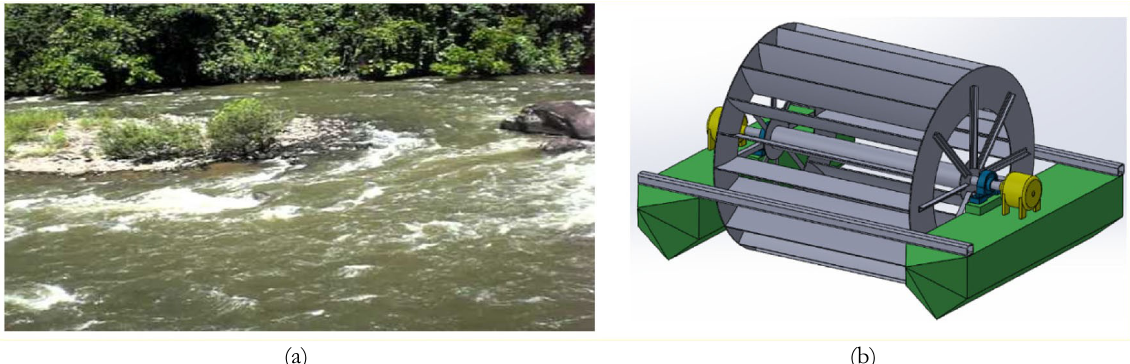
Figure 9. (a) river water flow, (b) the design of water wheel for a power